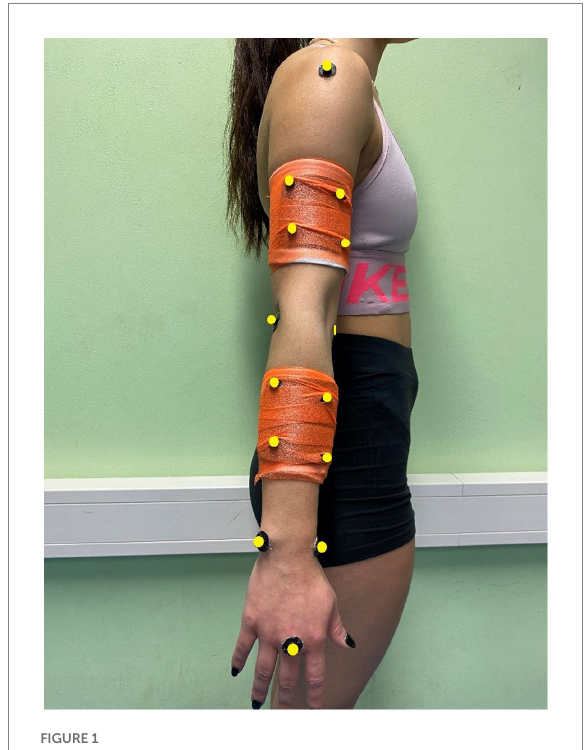
FIGURE 1 Marker placement on the participant dominant